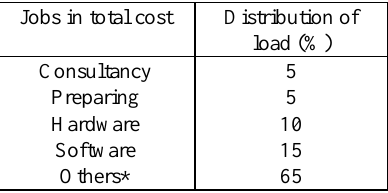
Table 2. Distribution of load of jobs for every components within total cost. (Köktürk, E. and Köktürk, E. 2002). Others item in Table 2. in above is covering identification, compilation and structuring of data.